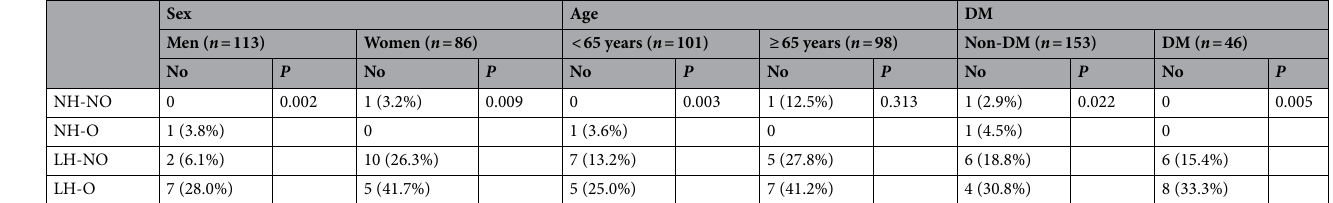
Table 3. The numbers of patient deaths at the end-point of follow-up in the subgroups. Multivariate analysis was adjusted for age and serum albumin with P < 0.05 in univariate analysis. No., numbers of patient death at the end-point of follow; P , P -value; NH-NO patients with normal handgrip strength and without obesity; NH- O patients with normal handgrip strength and with obesity; LH-NO patients with low handgrip strength and without obesity; LH-O patients with low handgrip strength and with obesity; DM diabetes